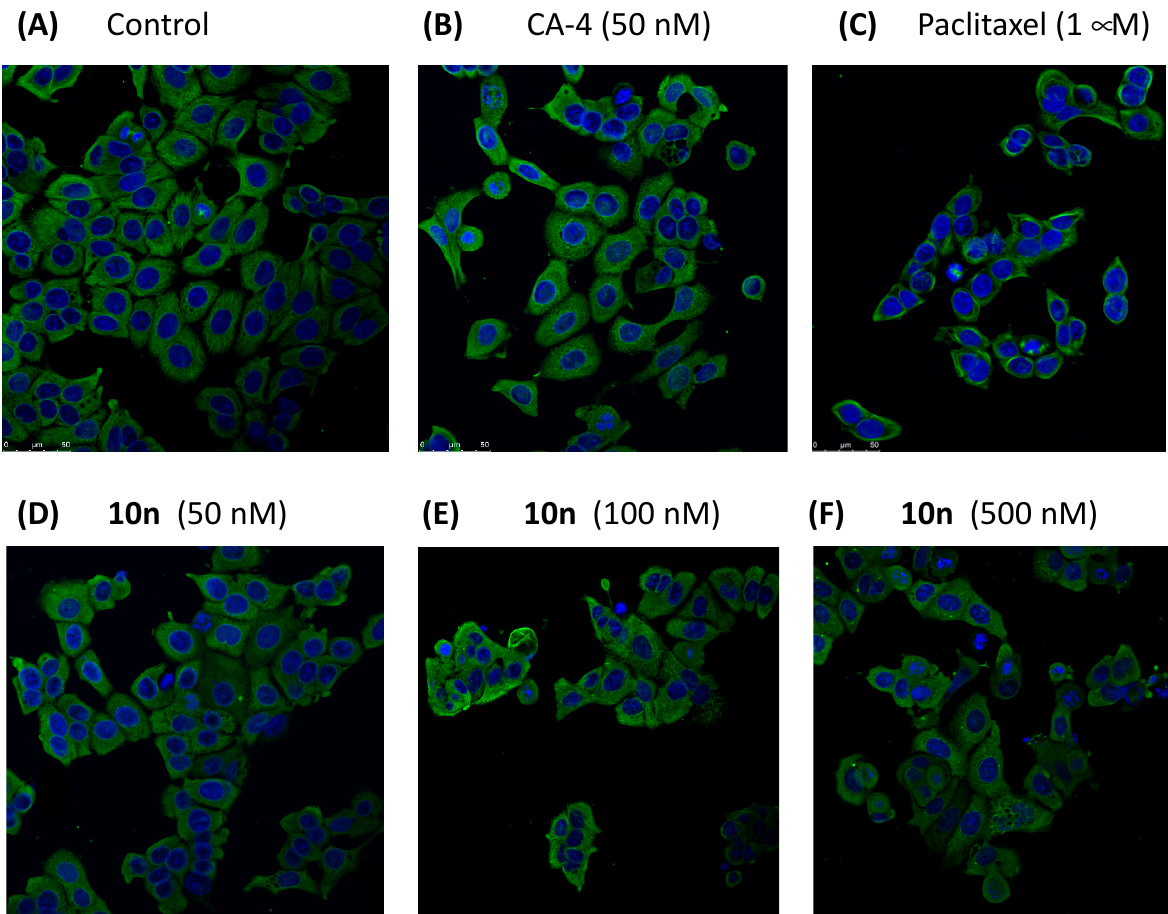
Figure 8. Compound 10n depolymerises the microtubule network of MCF-7 breast cancer cells. Cells were treated with ( A ) vehicle control (0.1% ethanol ( v / v )), ( B ) CA-4 (50 nM), ( C ) paclitaxel (1 µ M) and compound 10n , ( D ) (0.05 µ M), ( E ) (0.1 µ M) and ( F ) (0.5 µ M) for 16 h. Cells were fixed in ice-cold methanol and stained with mouse monoclonal anti- α -tubulin– FITC antibody (clone DM1A) (green), Alexa Fluor 488 dye and counterstained with DAPI (blue). Images were obtained with Leica SP8 confocal microscopy with Leica application suite X software. Representative confocal micrographs of three separate experiments are shown. Scale bar indicates 25 μ m.